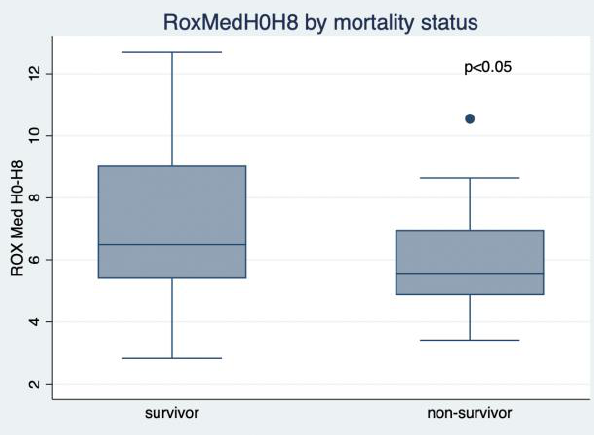
Figure 2. Median Rox index H0H8 by mortality status.